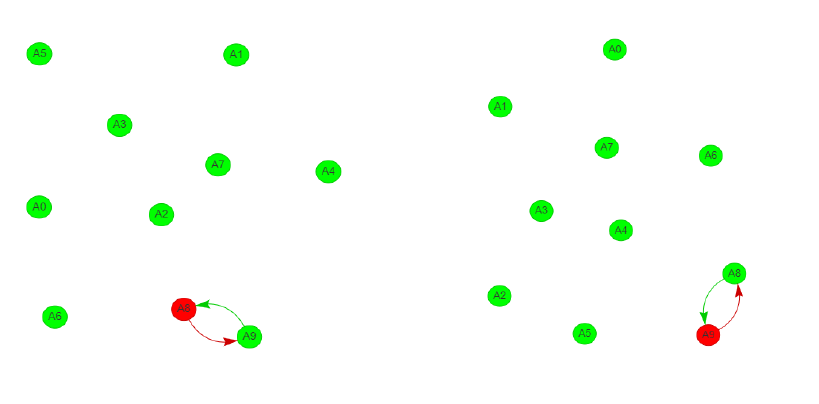
Figure 8. ASPIC+ argumentation graph evaluation under complete semantics. According to the solution on the left, argument A 9—the one for Marys’s innocence—is accepted. Conversely, according to to solution on the right, Mary should be considered liable ( A